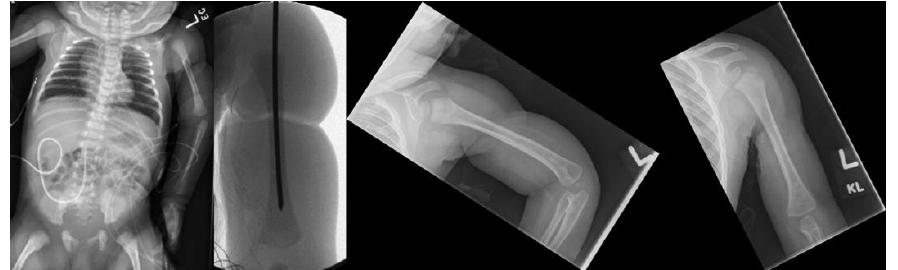
Figure 3. Radiographs of Patient 2: preoperative AP view, intraoperative AP view, and 1-year postoperative AP views of flexed and extended left upper extremity (left to right).